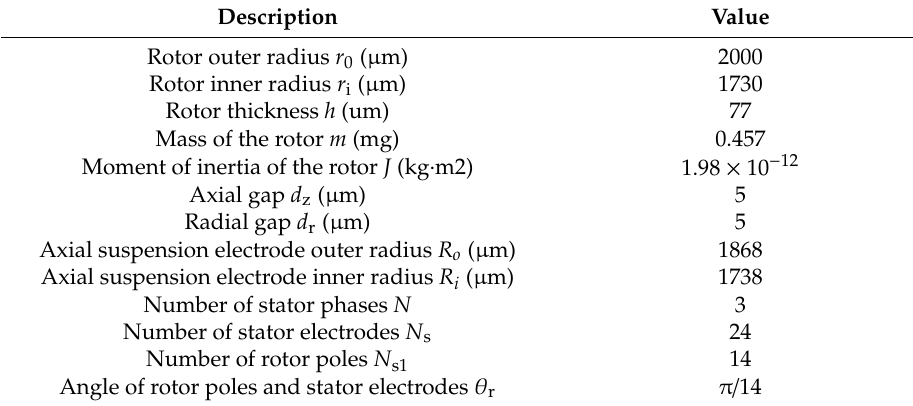
Figure 1. Micromachined electrostatically suspended gyroscope: ( a ) an exploded view of the device and ( b ) the fabricated die. Table 1. Main parameters of the micromachined electrostatically suspended gyroscope (MESG) structure.